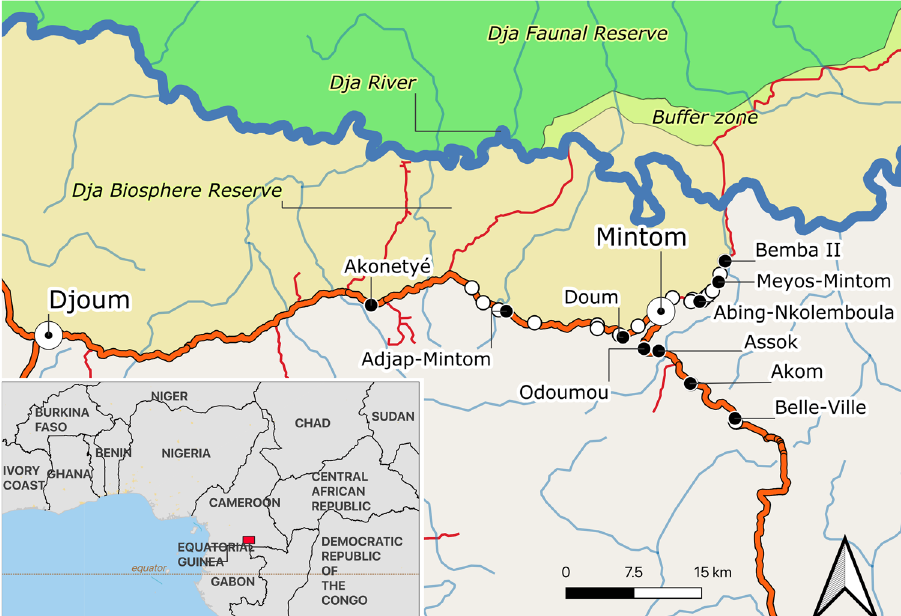
Figure 1. Map of the study area indicating the location of the regional cities Djoum and Mintom, the 10 Baka study villages (black circles) and neighbouring Bantu-speaking farmer villages (white circles) in southeastern Cameroon. Only villages between Akonetyé in the West, Bemba II in the Northeast and Belle-Ville in the Southeast are shown. The map was created using QGIS version 3.16.0-Hannover (https ://qgis.org/en/site/) from public domain map datasets from Open Street Map (www.opens treet map.org), diva-gis (diva-gis.org) and Natural Earth (http://www.natur alear thdat a.com) and the published map of the Dja Biosphere Reserve 89